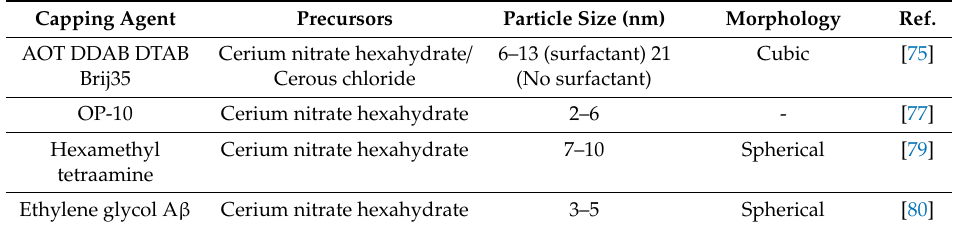
Table 2. Table showing the synthesis of cerium oxide nanoparticles using the microemulsion method. Capping